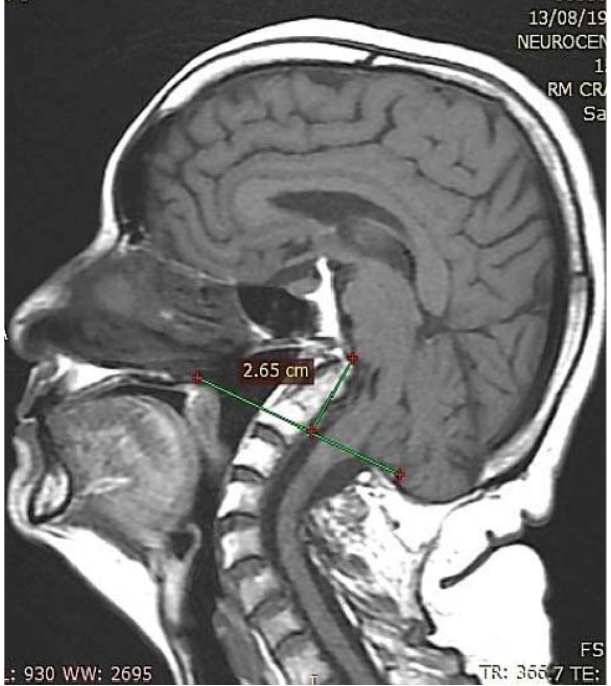
Figure 3 - The clivus is shortened, and the upper extremity of the odontoid process lies 26.5 mm across the Chamberlain line, consistent with basilar invagination, and compresses the pons